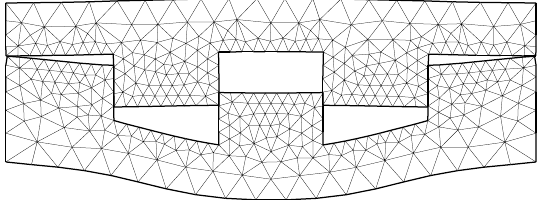
Figure 6.12 . Deformed configuration of the two viscoelastic bodies for µ = 0 . 125ns/m 2 and η = 0 . 05ns/m 2 .